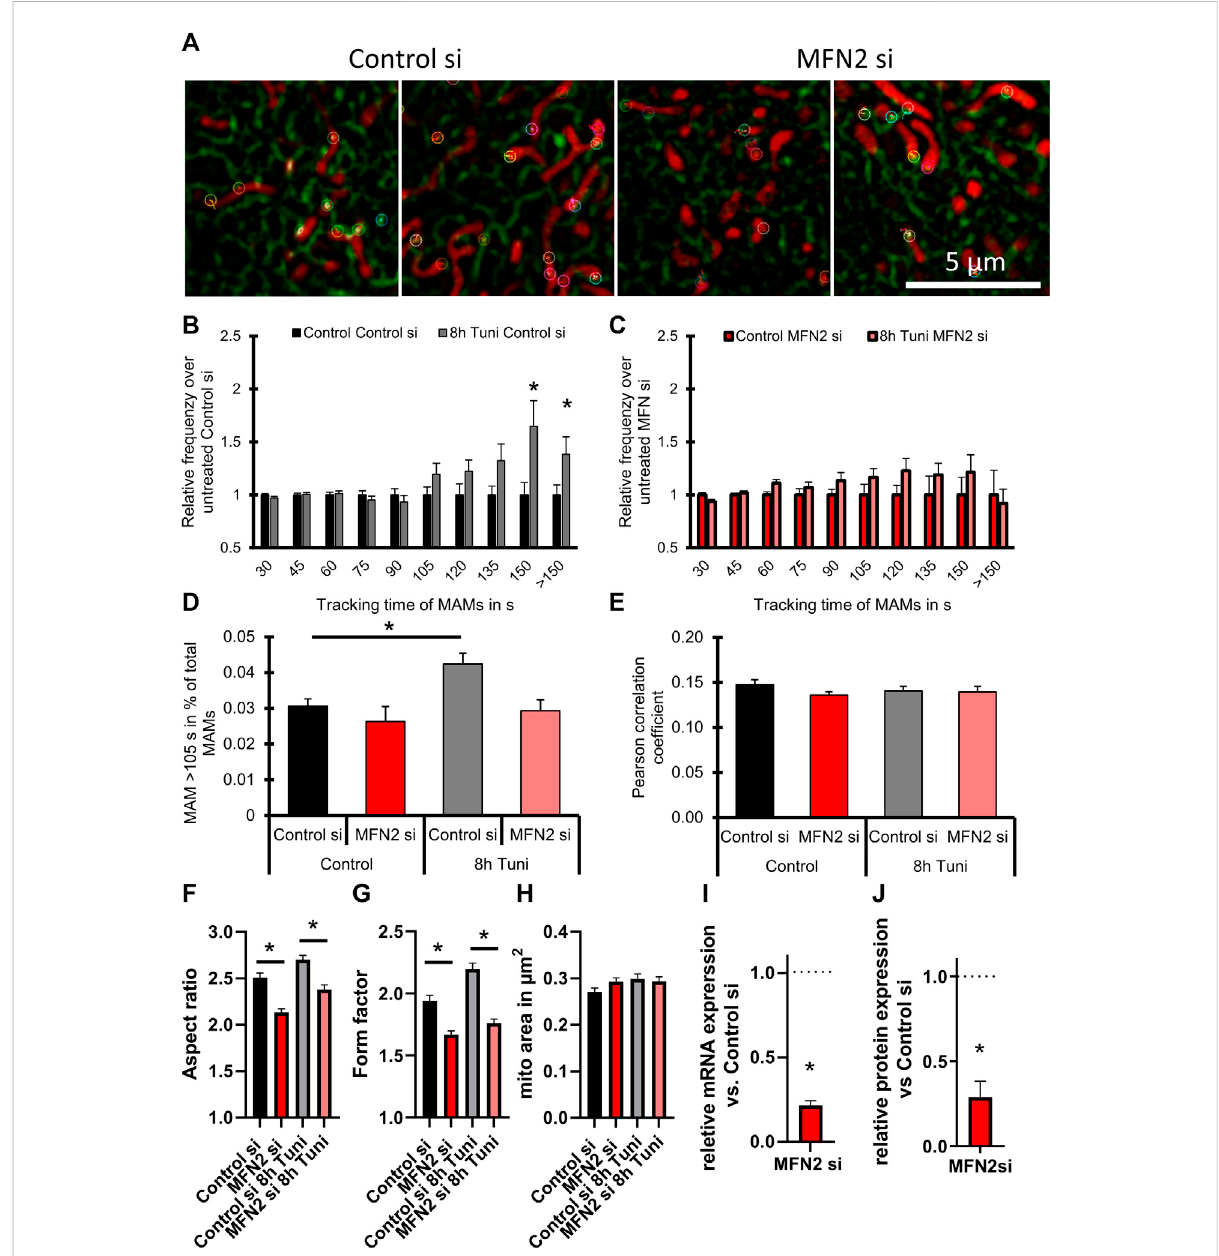
FIGURE 6 Silencing of MFN2 cancels ER-stress induced changes in MAM stability. (A) Representative images of HeLa cells expressing the ER marker ERAT4.01 NA, transfected with siRNA against MFN2 or Control siRNA were labeled with 100 nM TMRM and treated with 0.6 µM tunicamycin for 8 h or the respective control. Color coded markers show MAMs tracked for > 105 s. (B) The relative frequency (MEAN ± SEM) of MAMs isplottedover the tracking time of single MAMs of cells transfected with Control siRNA and treated with tunicamycin for 8 h. (C) The relative frequency of MAMs (MEAN±SEM)isplottedoverthetrackingtimeofsingleMAMsofcellstransfectedwithsiRNAagainstMFN2andtreatedwithtunicamycinfor8 h (D) A threshold of 105 s tracking time was set to de fi ne long lasting MAMs and the percentage of MAMs included in that group was plotted as a bar graph (MEAN ± SEM) for cells transfected with siRNA against MFN2 or Control siRNA and treated with tunicamycin for 8 h. (E) Bar graphs (MEAN ± SEM) shows Pearson ’ s correlation coef fi cient of control HeLa or HeLa cells treated with tunicamiycin for 8 h and transfected with siRNA against MFN2 or Control siRNA. (F) Bar graphs (MEAN ± SEM) shows mitochondrial aspect ratio of control HeLa or HeLa cells treated with tunicamiycin for 8 h and transfectedwith siRNA against MFN2 or Control siRNA. (G) Bar graphs (MEAN ± SEM) shows mitochondrial form factor of control HeLa or HeLa cells treated with tunicamycin for 8 h. (H) Bar graphs (MEAN ± SEM) shows mitochondrial size of control HeLa or HeLa cells treated with tunicamycin for 8 handtransfectedwithsiRNAagainstMFN2orControlsiRNA(n controlsi/DMSO =3/35;n controlsi/8hTuni =3/32;n MFN2si/DMSO =3/34;n MFN2si/8hTuni =3/ 28). (I) Veri fi cation of knockdown ef fi ciency by qRT-PCR (MEAN ± SEM) of MFN2 after treatment with control siRNA or siRNAs against MFN2 ( n = 3). (J) Veri fi cation of knockdown ef fi ciency by Western blot (MEAN ± SEM) of MFN2 after treatment with control siRNA or siRNAs against MFN2 ( n = 3). * p < 0.05 vs. respective control conditions carried out with one-way ANOVA with Tukey corrected posthoc